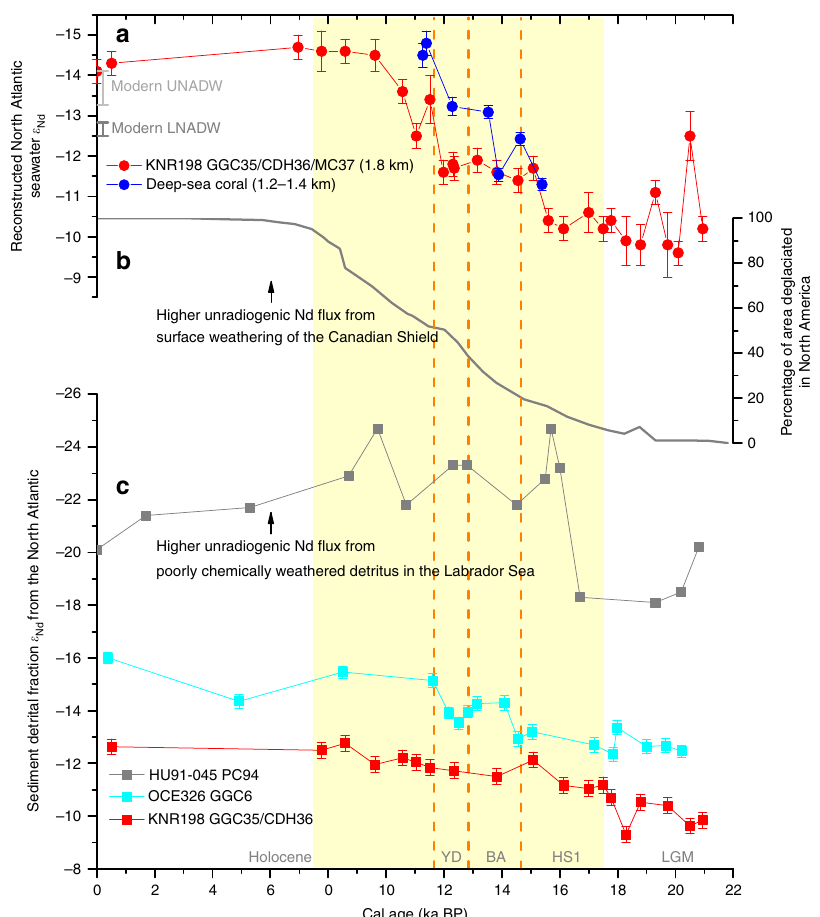
Fig. 2 Reconstructed North Atlantic seawater ε Nd in comparison with North American ice sheet deglacial history and North Atlantic detrital ε Nd records. a ε Nd of foraminiferal Fe – Mn coatings from this study compared to deep-sea coral records 33 and modern ε Nd ranges for Upper and Lower NADW based on GEOTRACES GA02 Station 19 (ref. 11 ). b Percentage of area deglaciated in North America with reference to the maximum NAIS extent during the LGM (ref. 34 ). c Sediment detrital fraction ε Nd from HU91-045-PC94 (ref. 64 ), OCE326-GGC6 (ref. 31,72 ), and KNR198-GGC35/CDH36 (this study). Error bars plotted are 2 σ . Yellow bar represents the interval of NAIS deglaciation, as also in later fi gures. Vertical orange lines denote boundaries between climate intervals. YD: Younger Dryas; BA: Bølling – Allerød; HS1: Heinrich Stadial 1; LGM: Last Glacial